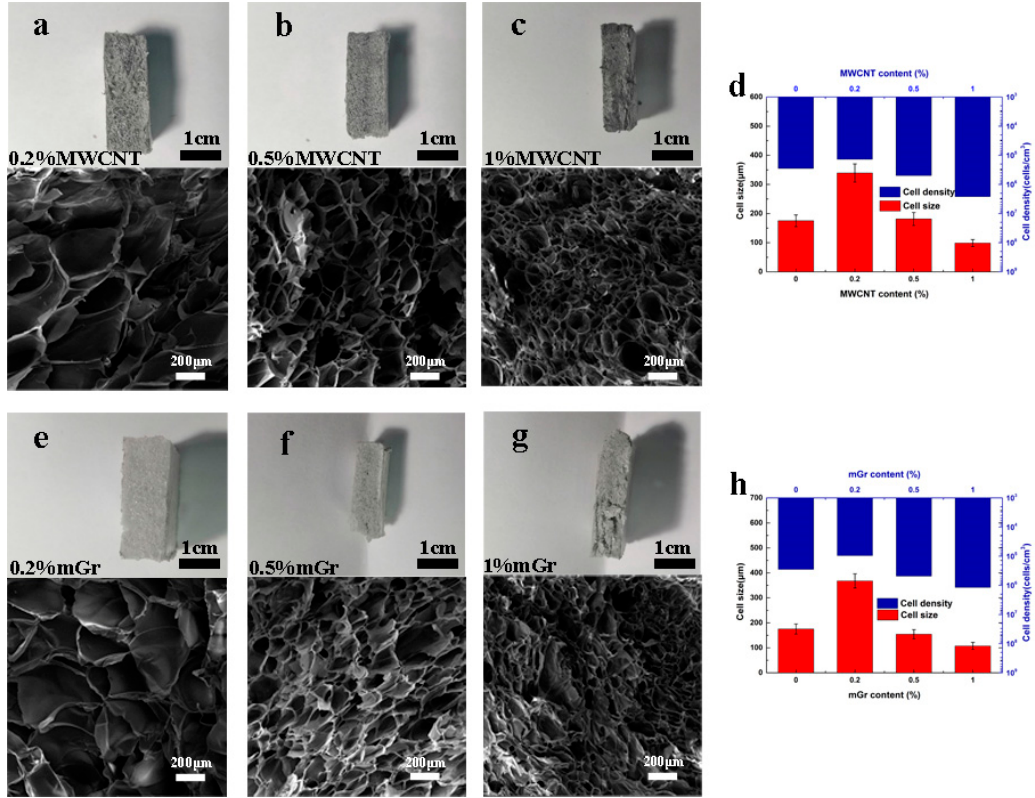
Figure 3. The cross-section view of extruded PS/carbonaceous fillers composite foams and representative cell morphology observed by SEM (the magnification ratio was 100 times). ( a ) 0.2 wt% MWCNT; ( b ) 0.5 wt% MWCNT; ( c ) 1 wt% MWCNT; ( d ) the cell size and cell density of PS/MWCNT composite foams; ( e ) 0.2 wt% mGr; ( f ) 0.5 wt% mGr; ( g ) 1 wt% mGr; ( h ) the cell size and cell density of PS/mGr composite foams.